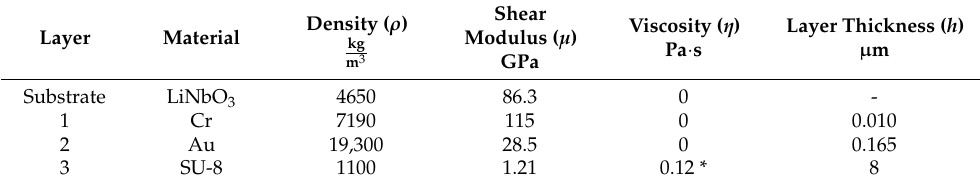
Table 2. Material properties for simulation of the Love wave